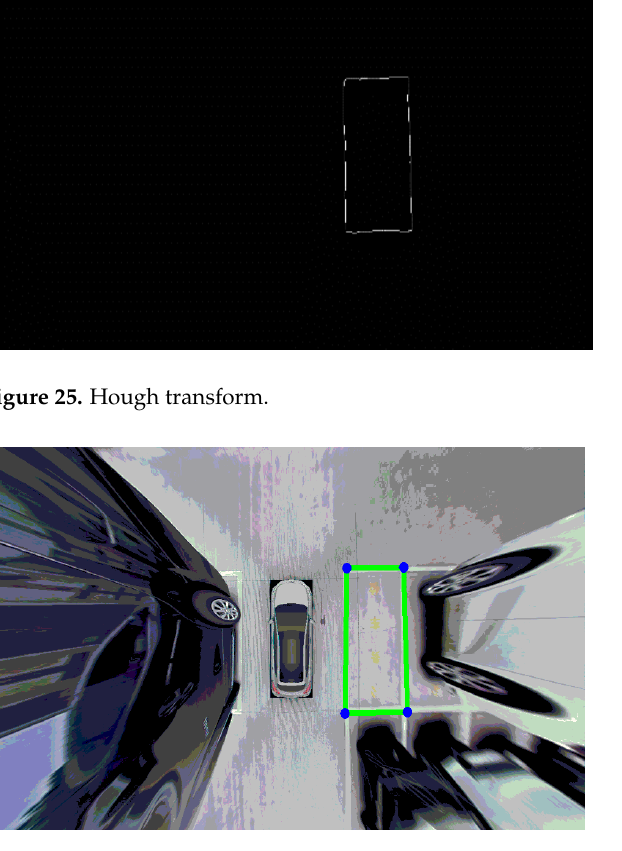
Figure 26. Coordinate transformation.